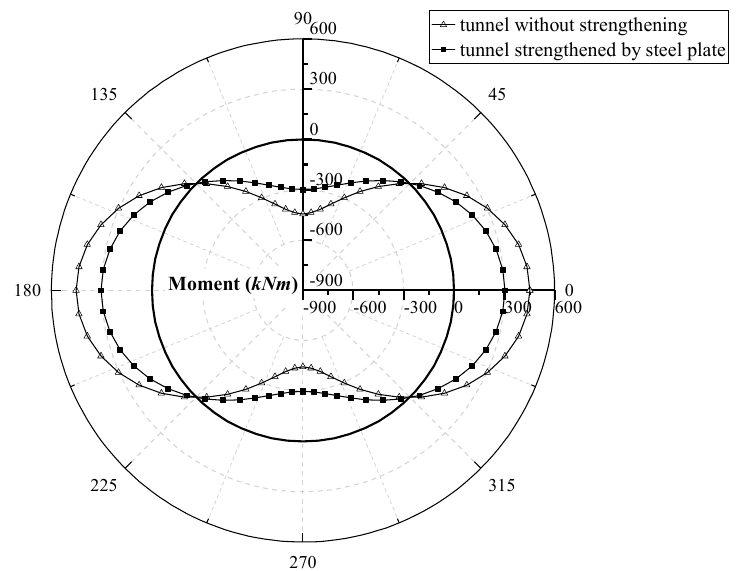
Figure 11. Comparison of moment in the concrete lining of tunnels with and without steel plate strengthening.